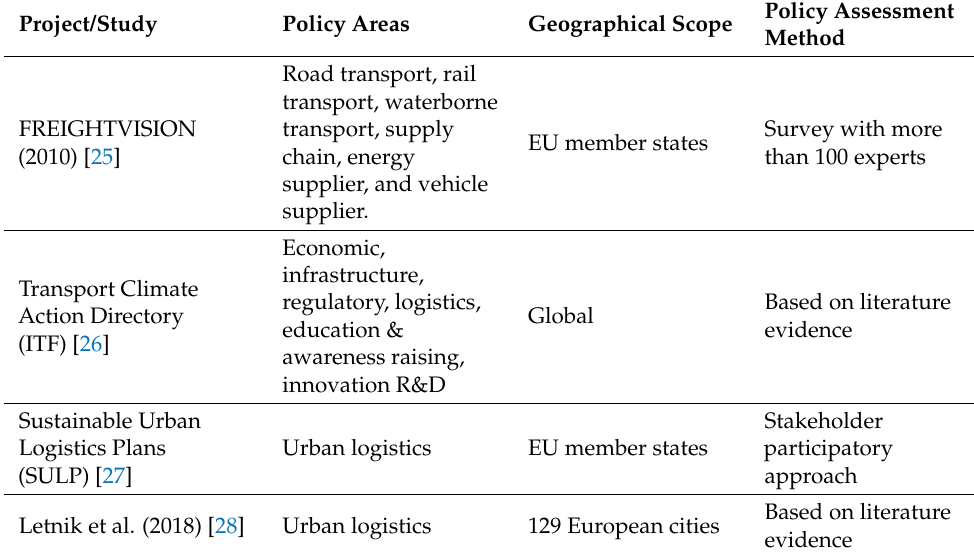
Table 3. Policy Studies and Projects on Sustainable Freight